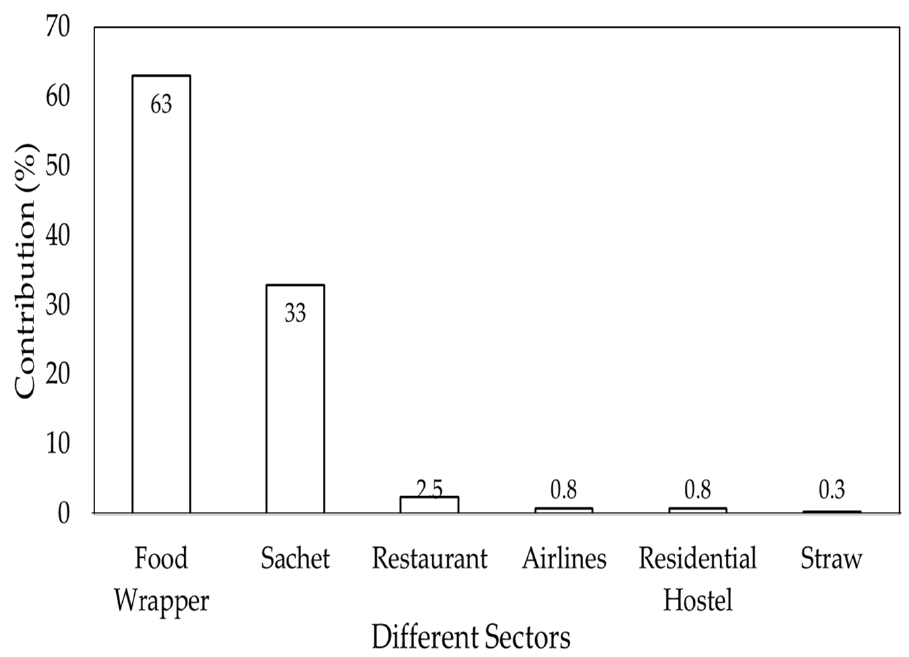
Figure 2. Usage of single-use plastic in different sectors of Bangladesh.